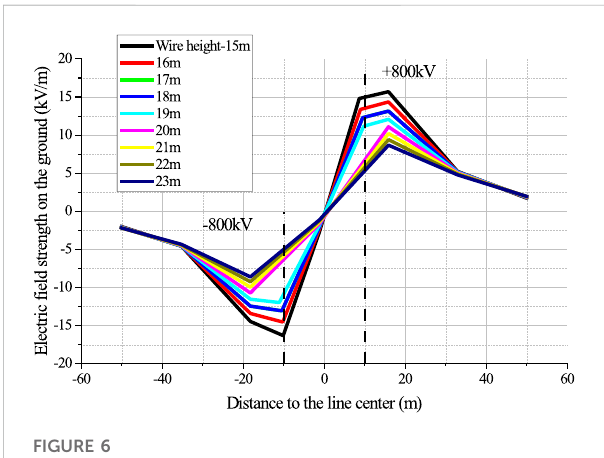
FIGURE 6 Distribution rules of ground fi eld under ± 800 kV power lines with different heights above ground.